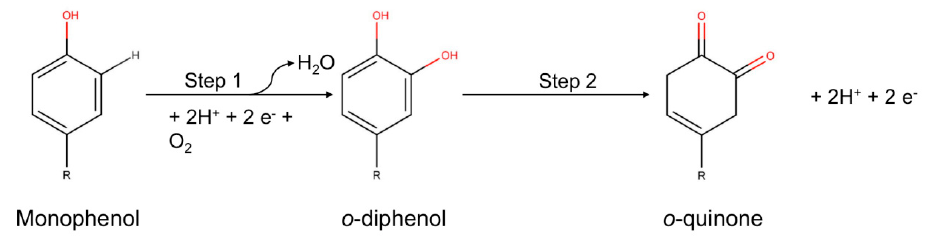
Figure 3. Reactions catalyzed by tyrosinase.